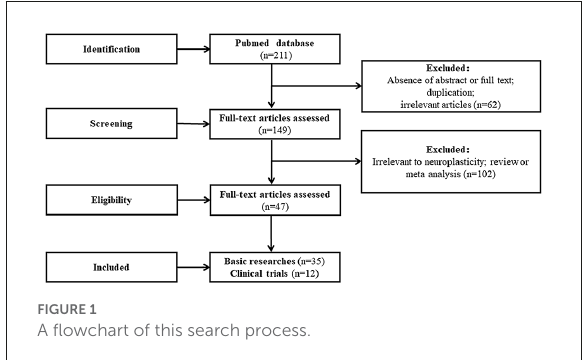
included in our review. A flowchart of this search process is illustrated in Figure 1